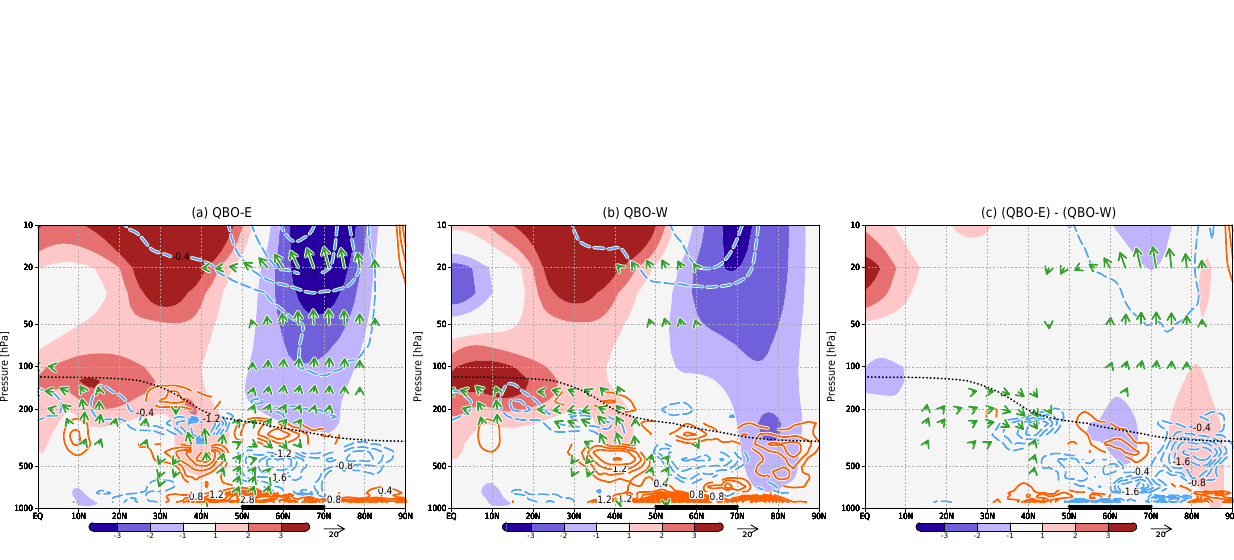
Figure E2. Same as Fig. D1d, but (a) for QBO-E, (b) for QBO-W, and (c) the difference between QBO-E and QBO-W. The black dashed line indicates the tropopause height defined by WMO